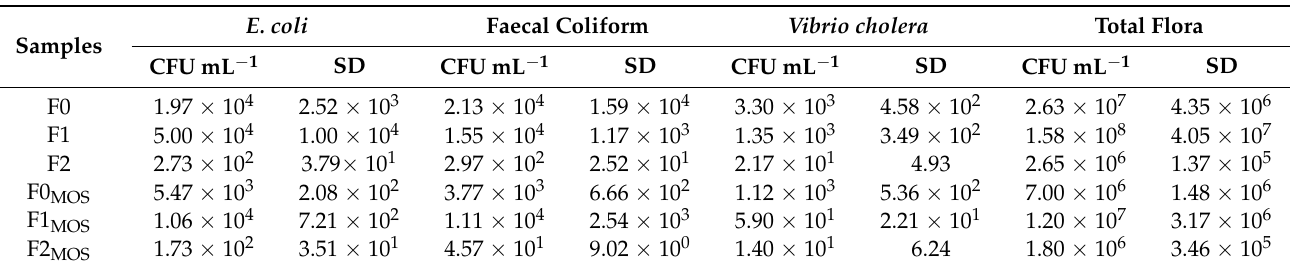
Table 2. Abundance of bacteria in